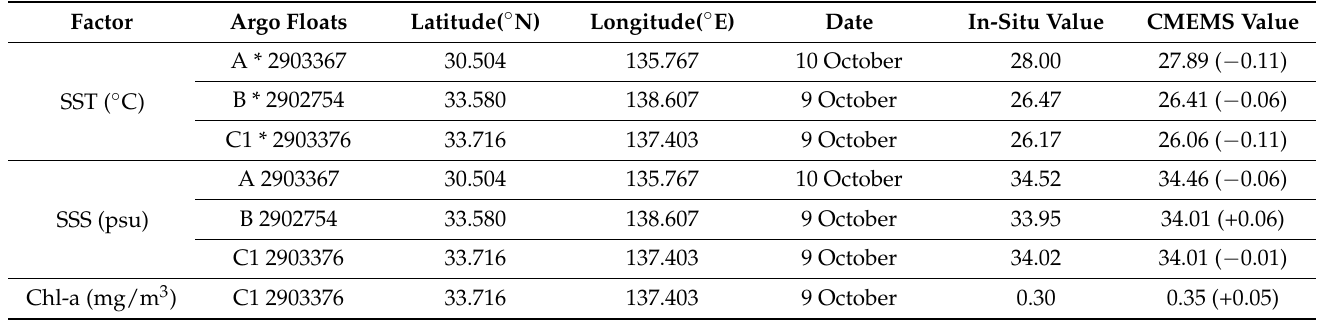
Table 2. Validation of oceanic CMEMS values in comparison to in-situ